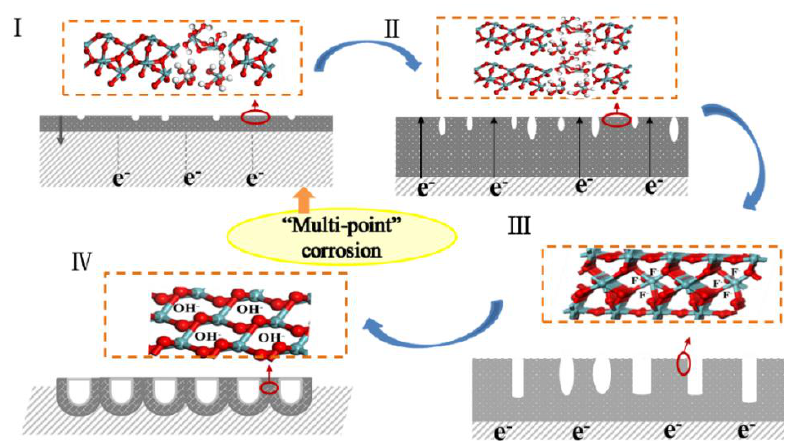
Figure 1. Schematic diagram of self-aligned process of niobium pentoxide nanotube arrays (NAs) by electrochemical anodization.